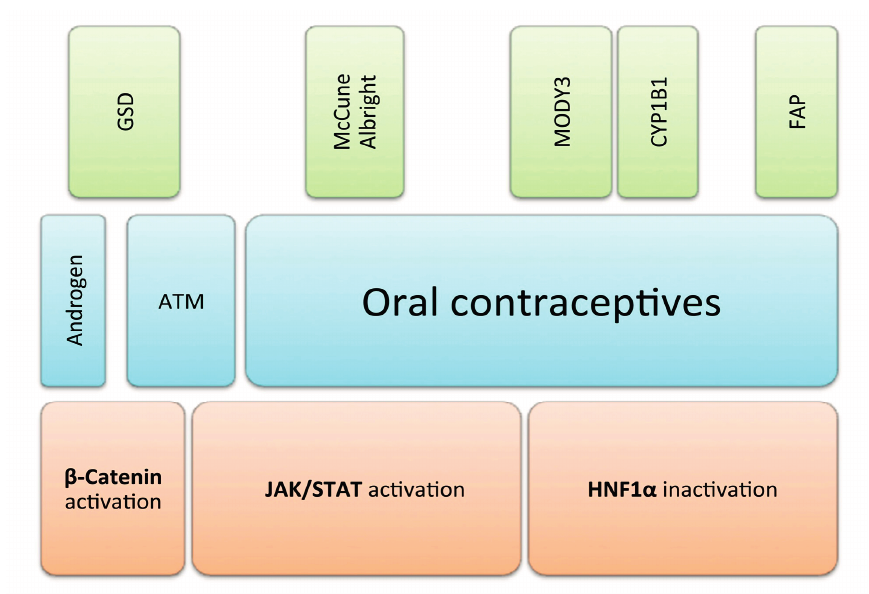
Figure 1. Risk factors of hepatocellular adenomas (HCA). Various genetically-defined predisposing factors are depicted in green. Blue bars represent environmental factors frequently associated with the development of HCA, second to none the use of oral contraceptives in females. Orange boxes in the lowermost line represent three distinguishable molecular pathways, which define the main subgroups of HCA. GSD: glycogenosis; FAP: familiar adenomatous polyposis; ATM: alcohol, tobacco, metabolic syndrome; JAK: Janus kinase; STAT: signal transducer and activator of transcription; HNF1 α : hepatocytic nuclear factor 1 α